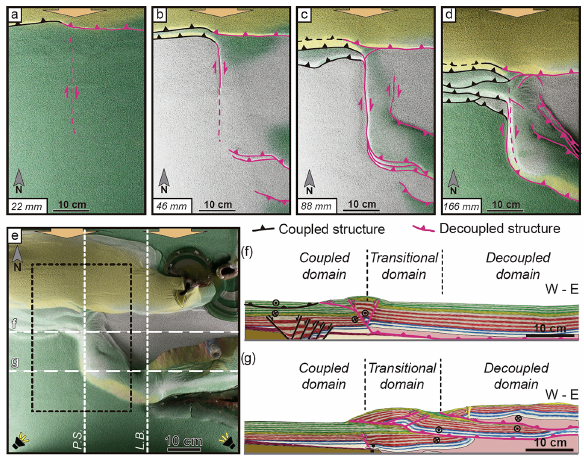
Figure 10. (a–d) Detail of the overhead evolution of the transitional domain in model 3 after 22, 46, 88, and 166mm of shortening, respectively. (e) Overhead view at the end of the model 3 (after 200mm of shortening). The black square indicates the location of Fig. 10d. (f , g) W–E cross-sections built from a 3D voxel show- ing the structural style of the transitional domain (see location in Fig. 10e).